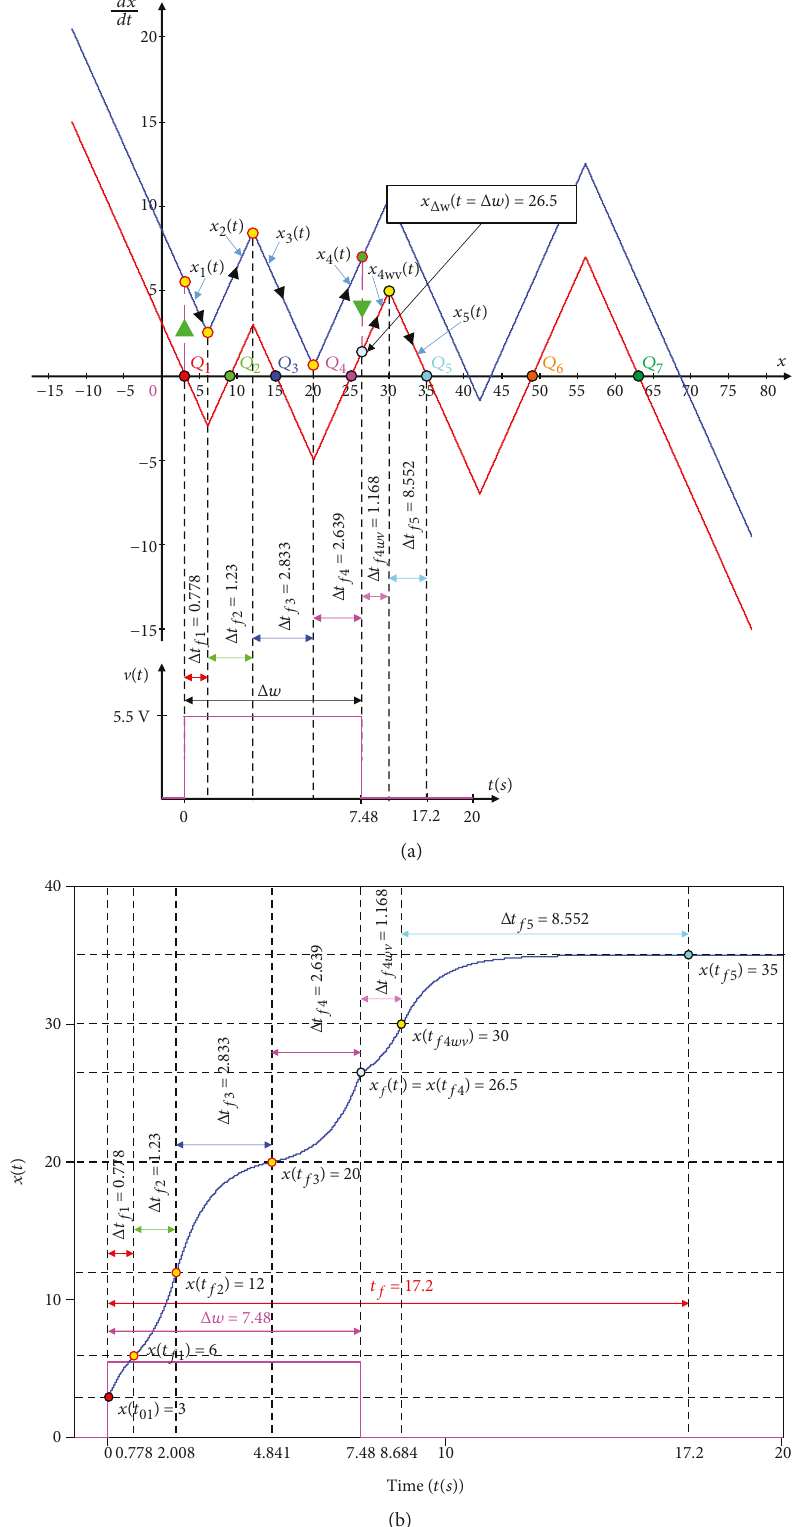
Figure 6: Memory state switching kinetics of the 6-lobe Chua corsage memristor from memory state Q = 5 5 V and Δ w = 7 48s . (a) Dynamic routes of the switching kinetics of the 6-lobe Chua corsage memristor. The two magenta-color V A vertical line segments indicate an instantaneous jump between the red and the blue piecewise-linear plots in the dynamic route map. (b) Movement of the exponential trajectories of x t with respect to time t